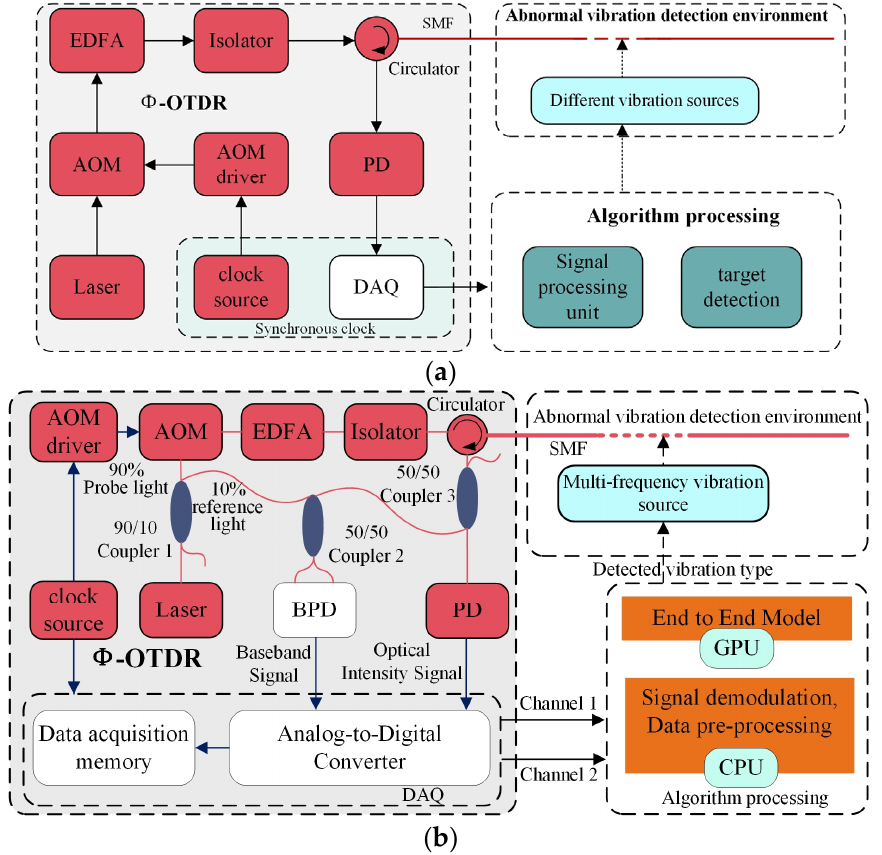
Figure 1. Overall system operation structure: ( a ) Φ -OTDR direct detection method; ( b ) Φ -OTDR hybrid detection method.